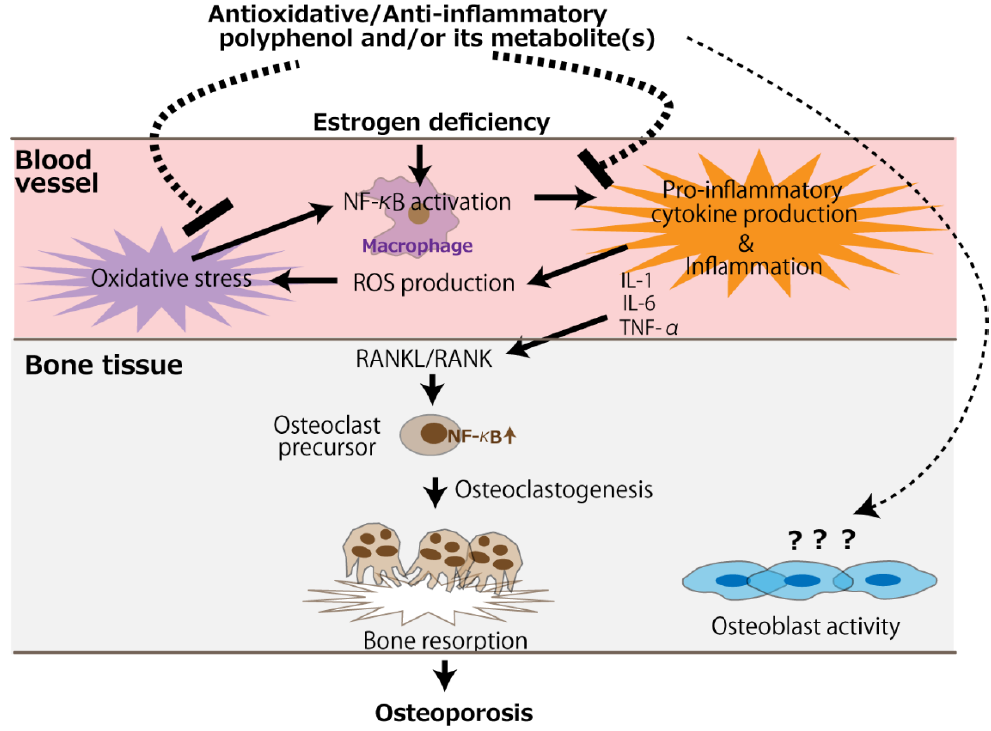
Figure 2. The putative mechanism of the antioxidative and anti-inflammatory effects of polyphenols for the prevention of postmenopausal osteoporosis. The arrows and dotted line indicate stimulation and suppression, respectively. ROS, reactive oxygen species.